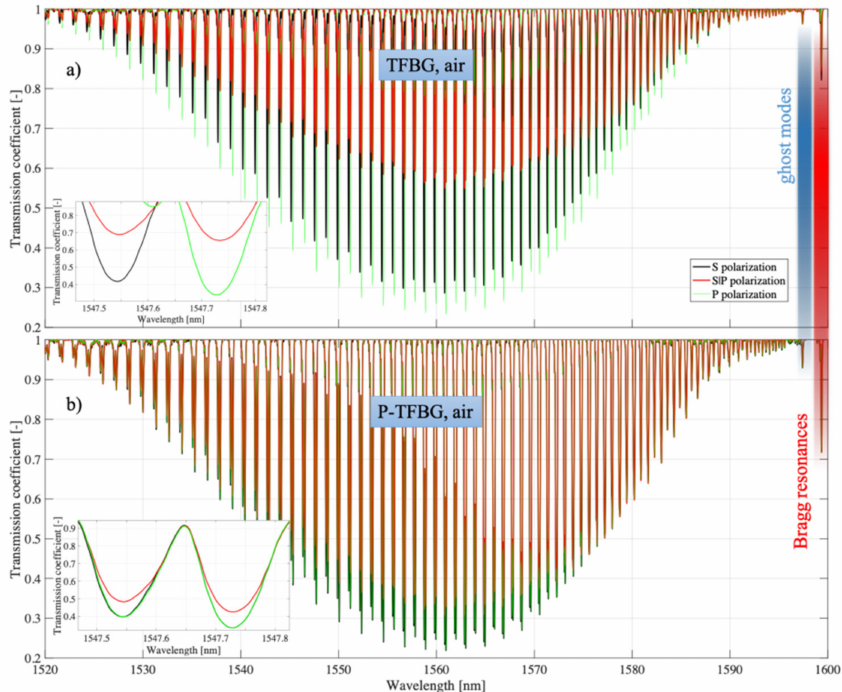
Figure 15. Spectral characteristics measured in air for three input light polarization states: ( a ) TFBG, ( b ) P-TFBG